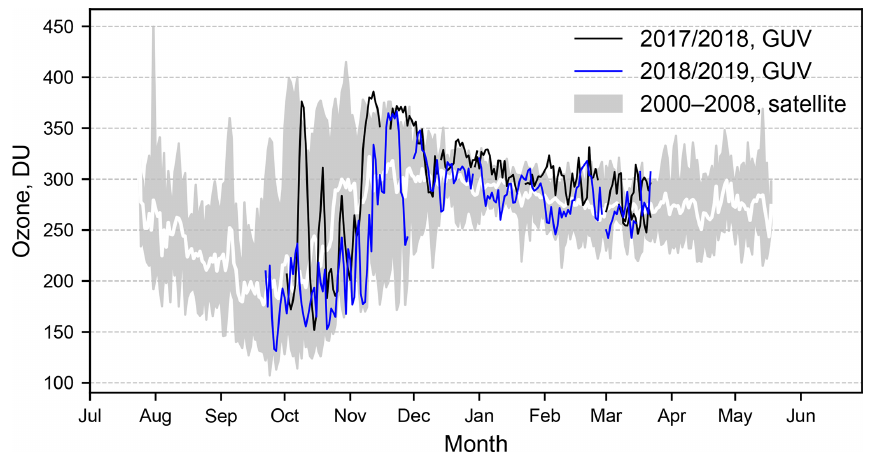
Figure 9. Comparison of TOC calculated from GUV in Marambio in seasons 2017/2018 (black line) and 2018/2019 (blue line) with long- term measurements (2000–2008) from satellites. The white line is the long-term daily average (2000–2008), and the grey area is the region between the period’s daily maxima and